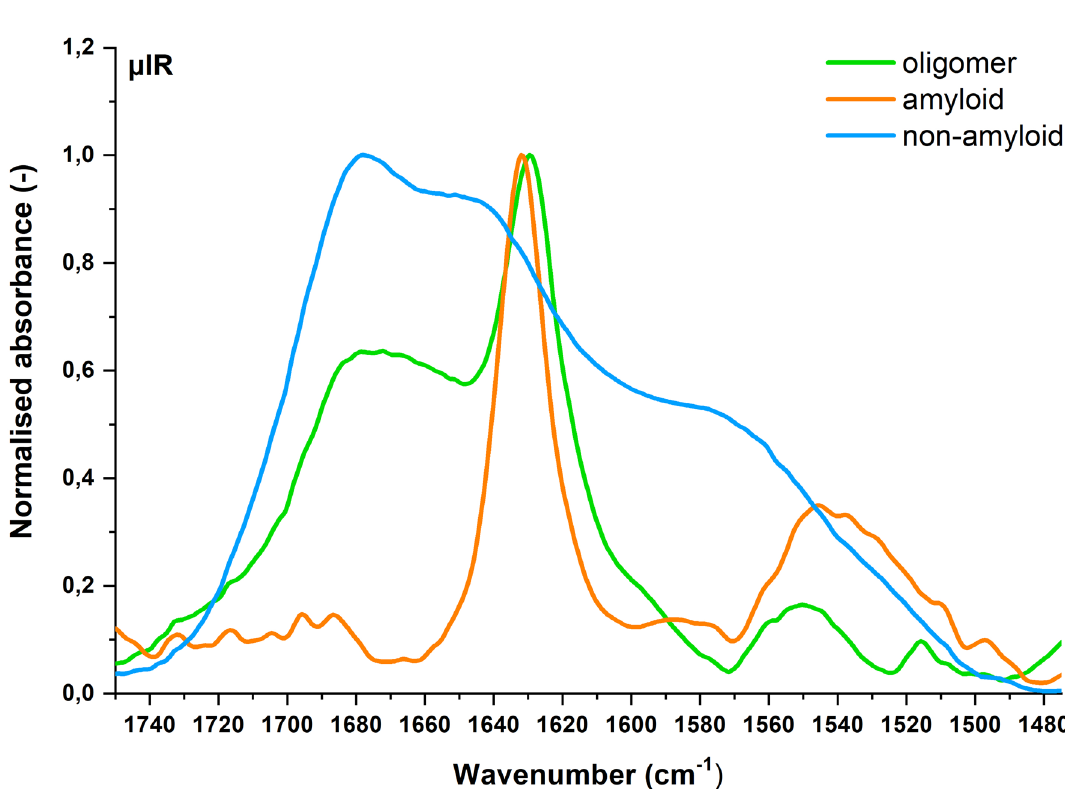
Figure 3. Representative IR microscopy spectra: amyloid (LVFYQQ) in red, oligomer (SFLIFL) in green, non- amyloid (KPAESD) in